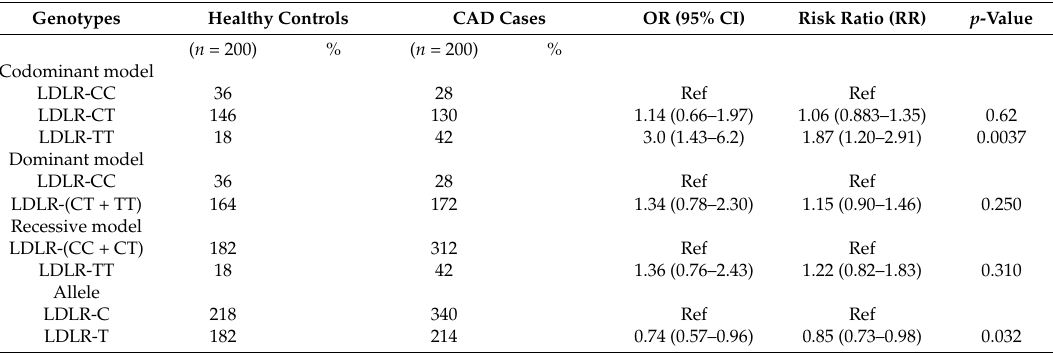
Table 6. Association of LDLR rs688C > T gene variation with